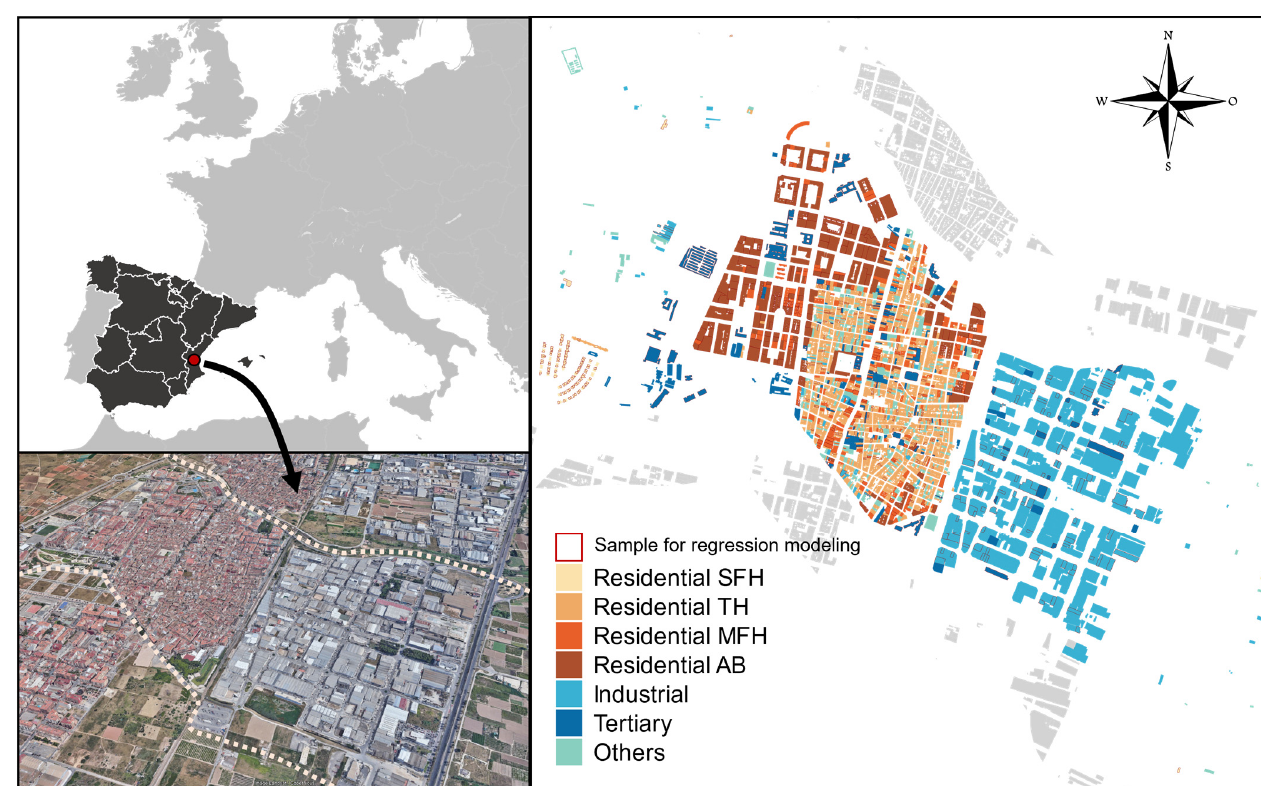
Figure 2. Geographical location and building typologies of Catarroja (Spain).